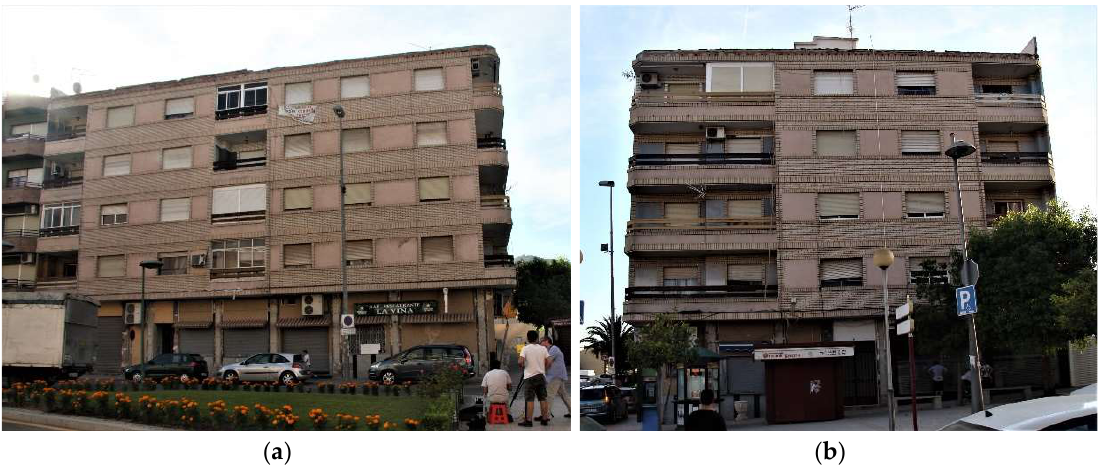
Figure 2. Main façades of the “La Viña” building: ( a ) longitudinal orientation, L; ( b ) transversal orientation, T.